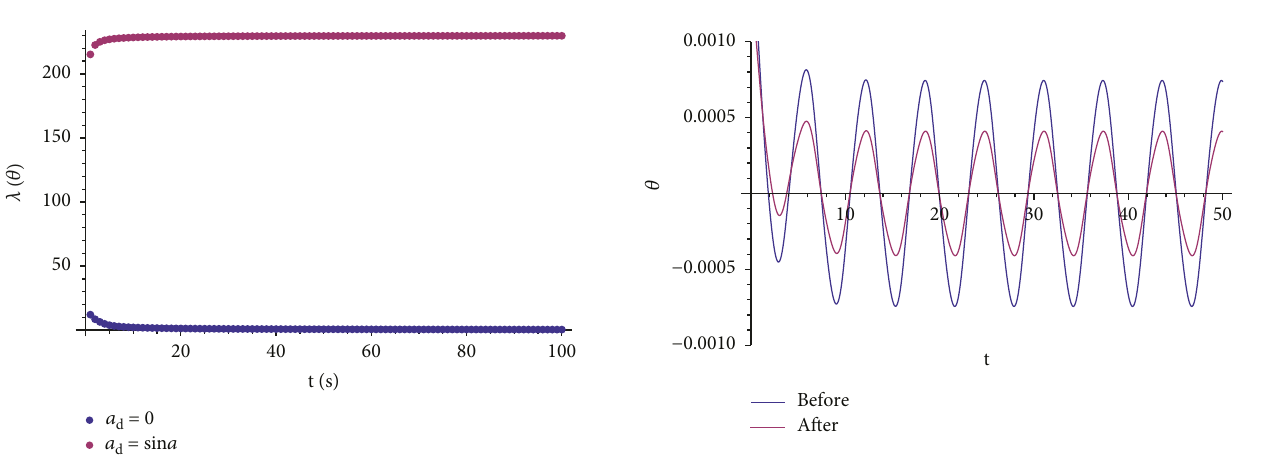
Figure 5: Lyapunov exponents of the pitch angles under two conditions.